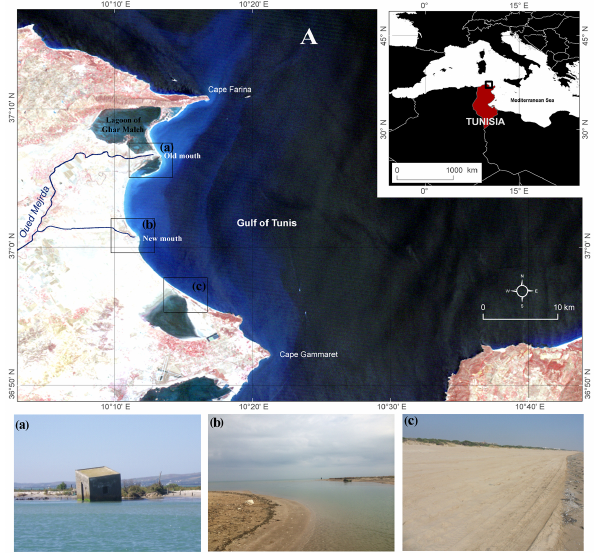
Figure 1. (A) Location map of the study site: the bay of Gulf of Tunis (Bay western). (a) Spit of Kalaât Andalous, (b) New mouth of Medjerda river and (c) Raoued beach. Table 1. Satellite imagery and maps used in the